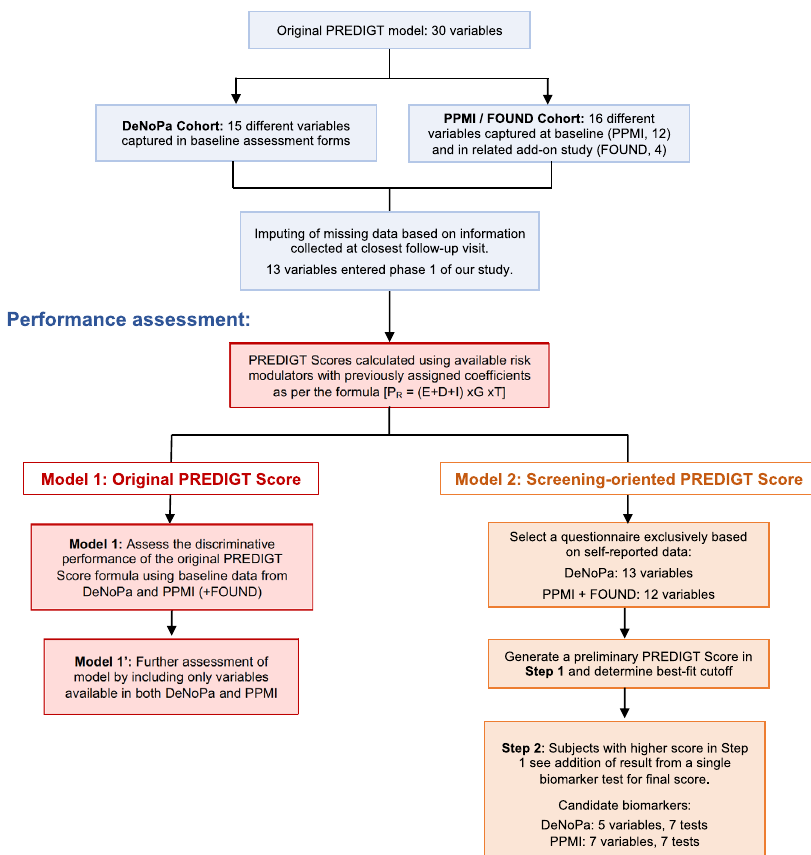
Fig. 1 Work fl ow of this study. DeNoPa denotes De Novo Parkinson Study; PPMI Parkinson ’ s Progression Marker Initiative, FOUND FOllow Up persons with Neurologic Disease cohort, AUC area under the receiver operating characteristic